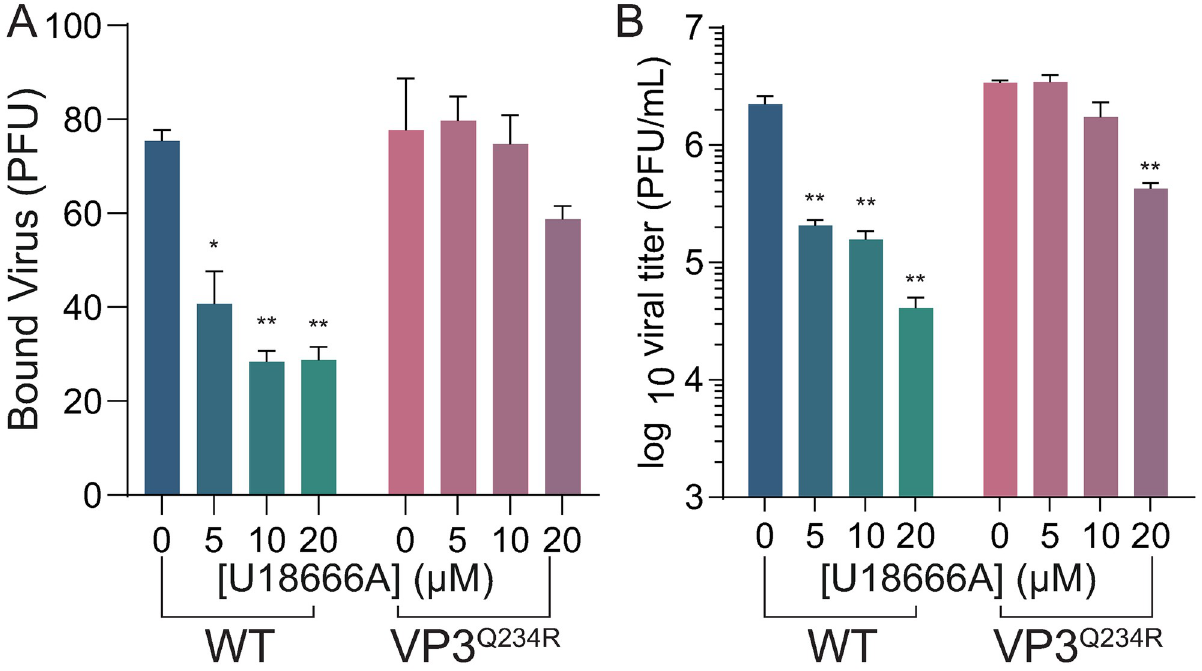
Fig 7. CVB3 VP3 Q234R mutant is resistant to reduction of cytoplasmic cholesterol. (A) Vero cells were treated with increasing doses of U18666A for 16h prior to binding WT and VP3 Q234R mutant CVB3. Bound virus was enumerated by counting plaques indicative of attached virus. (B) Vero cells were treated as in (A) and infected at MOI 0.1 with WT and VP3 Q234R mutant CVB3. Viral titers were determined at 24 hpi. * p < 0.05, ** p < 0.01 via Student’s t test from three independent